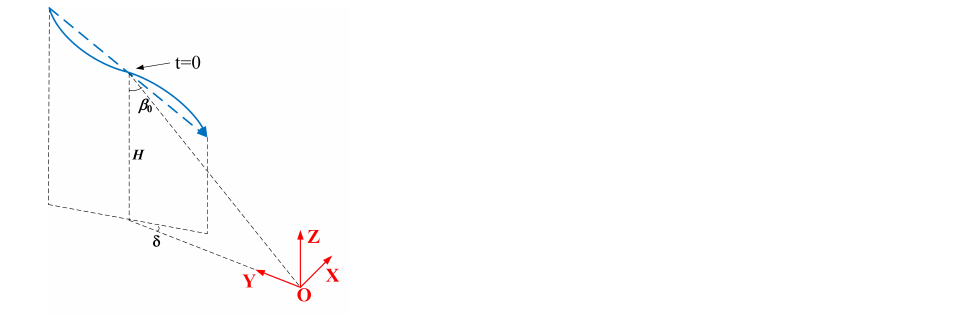
Figure 18. Geometry of extremely-high-squint SAR with non-ideal